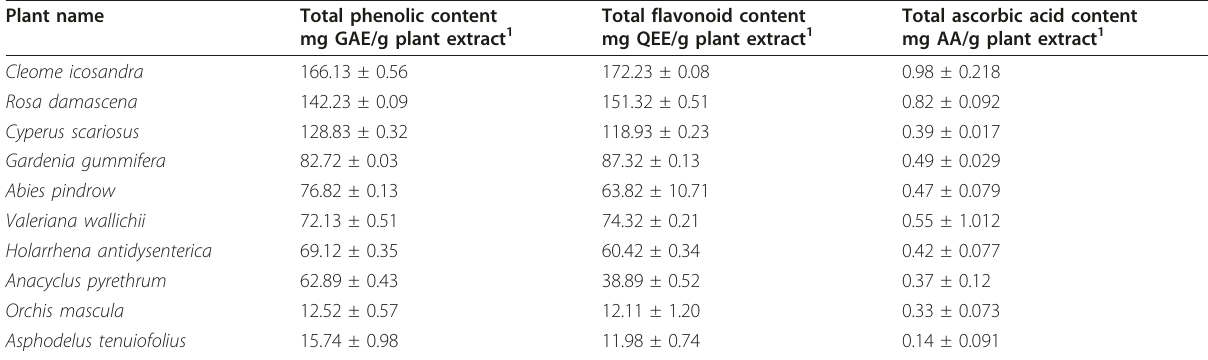
Table 2 Total phenolic, flavonoid and ascorbic acid contents of plant